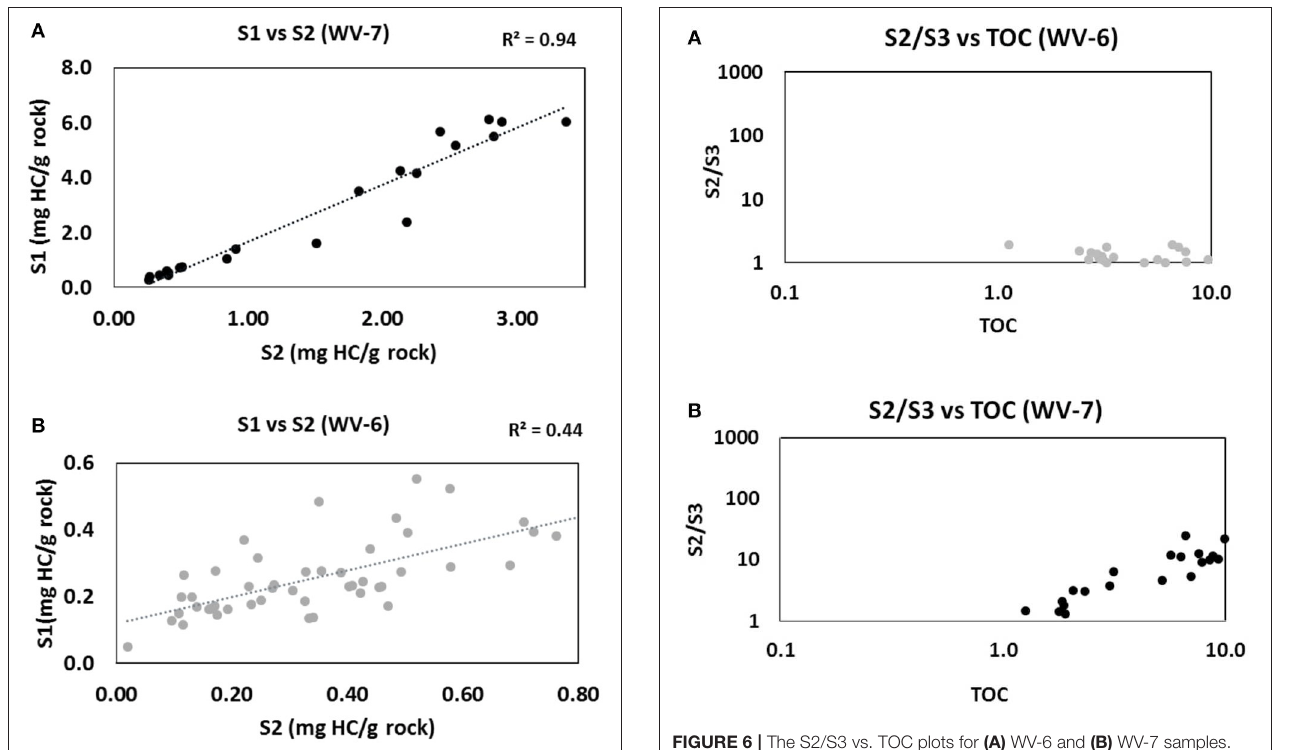
FIGURE 5 | The S1 vs. S2 plots for (A) WV-7 and (B) WV-6 samples.